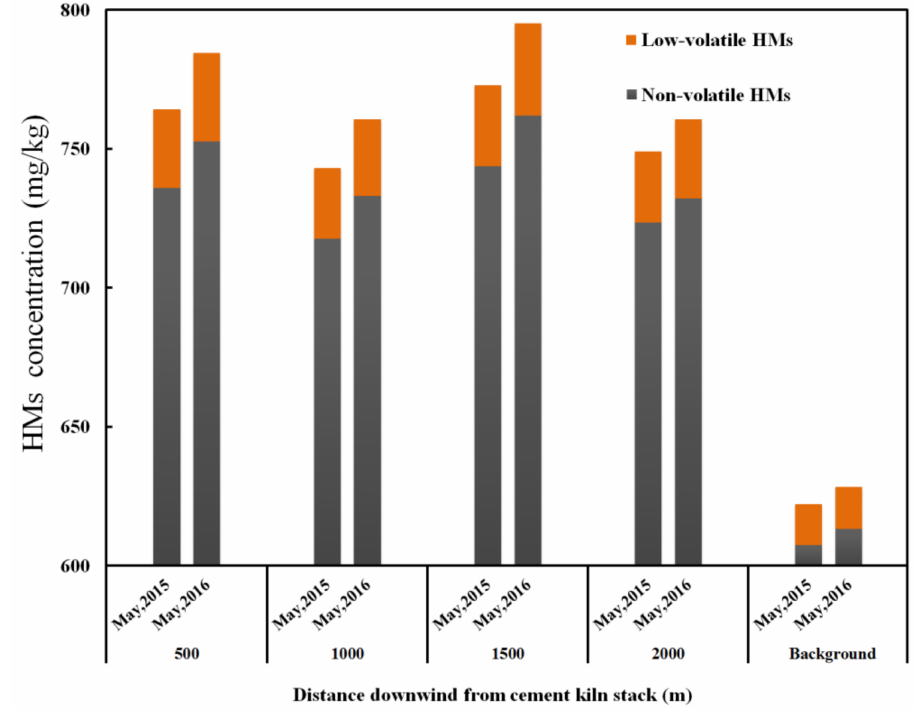
Figure 5. Heavy metals concentration in soil in different sampling sites and